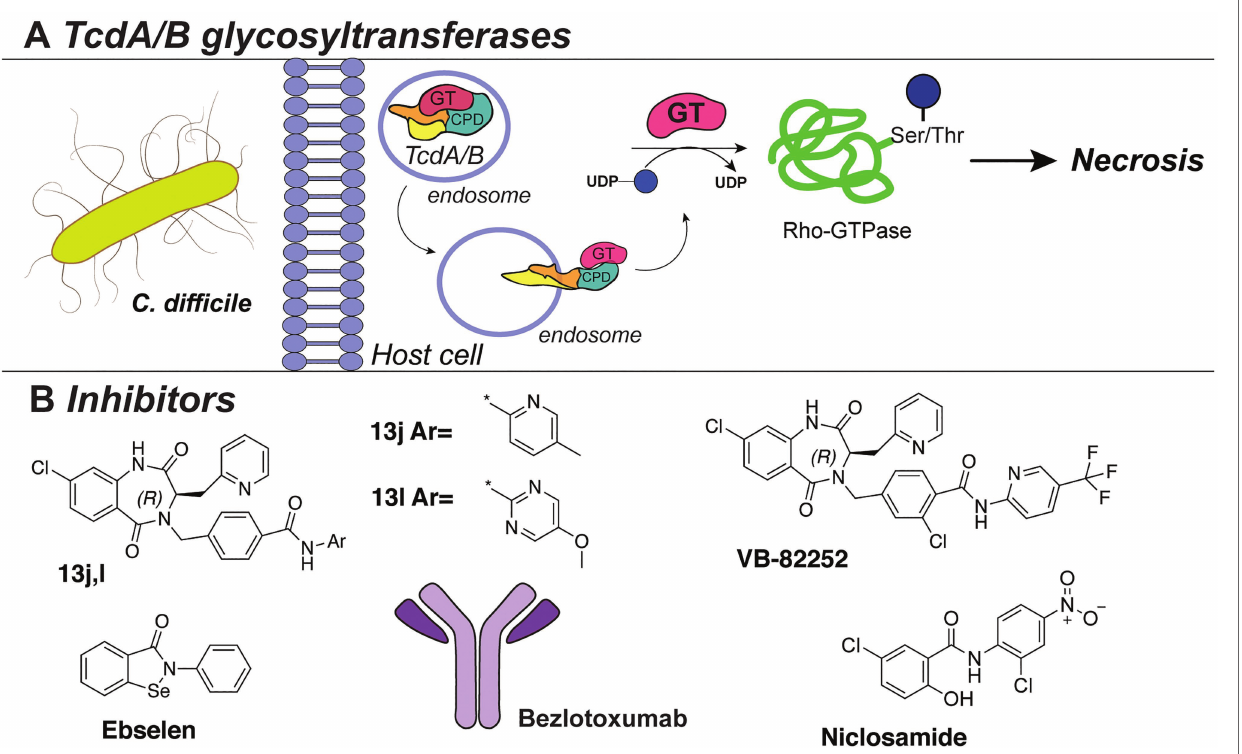
FIGURE 8 | (A) The TcdA/TcdB bacterial exotoxin system. (B) Inhibitors against TcdB discussed in this